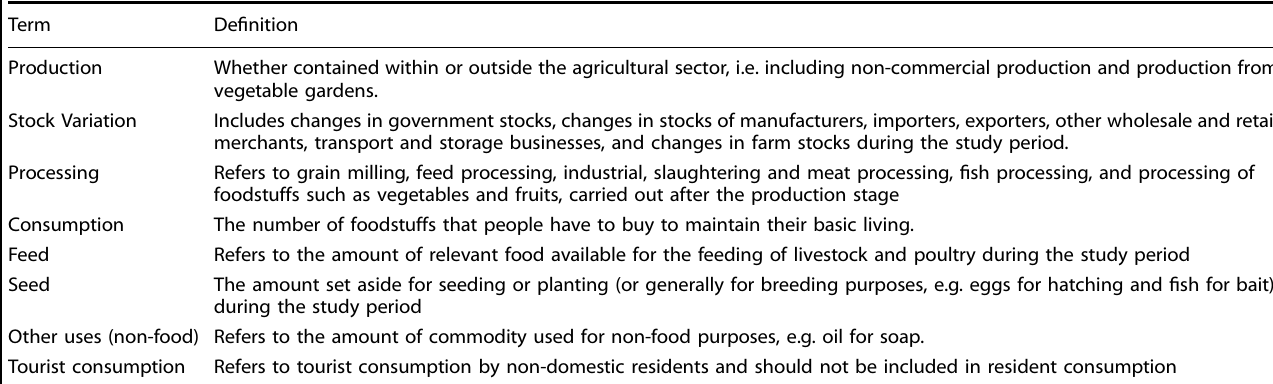
Fig. 5 Diagrammatic representation of food loss and waste at various stages of the food supply chain. The fl ow paths of the seven food categories in the material fl ow analysis system, the food supply chain from agricultural production to postharvest handling and storage, processing and packaging, distribution, and resident consumption across fi ve stages. There are feed, seed, and other uses (non-food) uses of food in the handling stage. Food imports occur in the processing and packaging, while, exports occur in the distribution and tourist consumption in the consumption stage. S refers to stock, F refers to fl ow, W refers to waste, and k refers to the waste rate in a stage. Table 3. Term used in